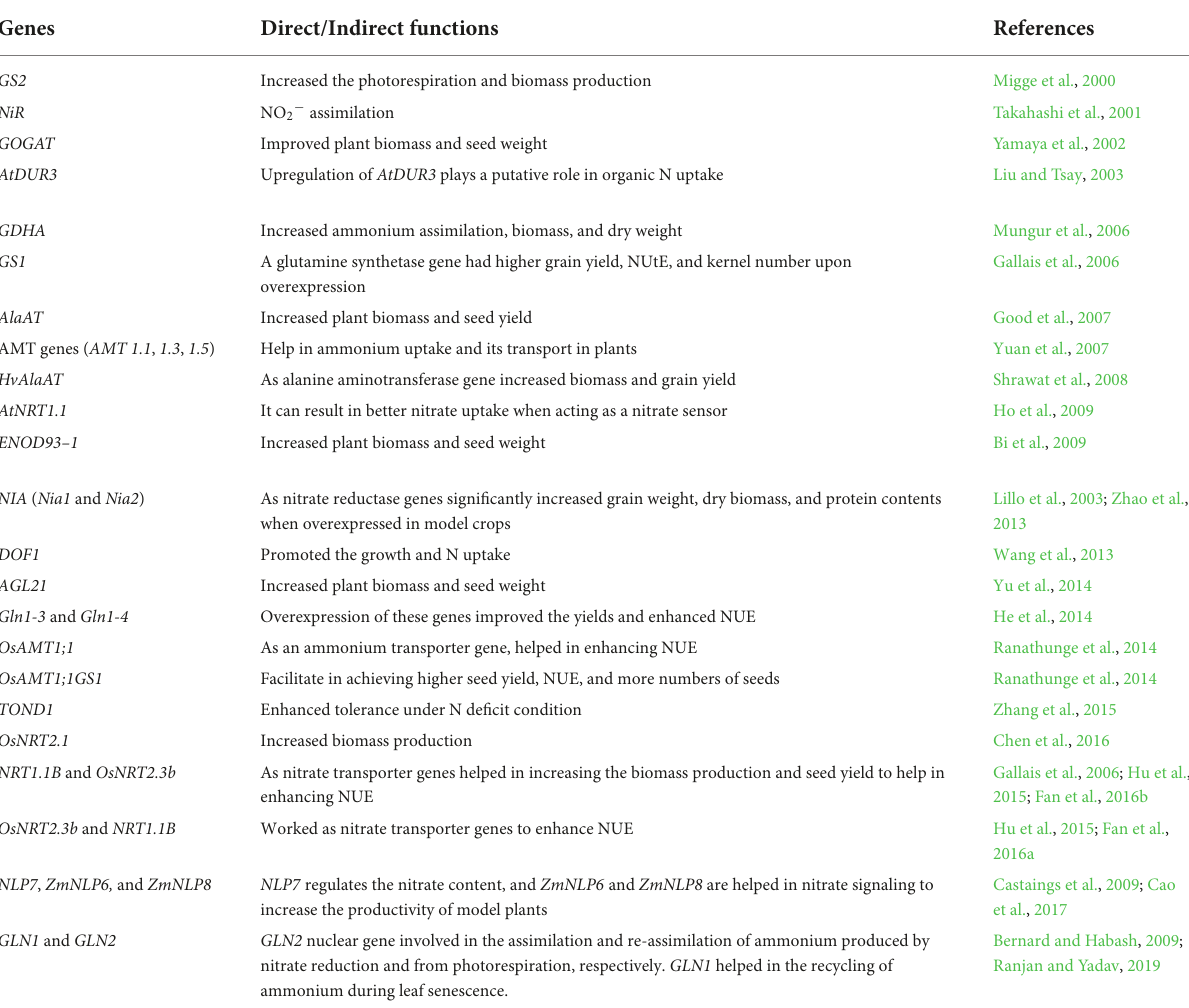
TABLE 3 Genes directly or indirectly involved in nitrogen use